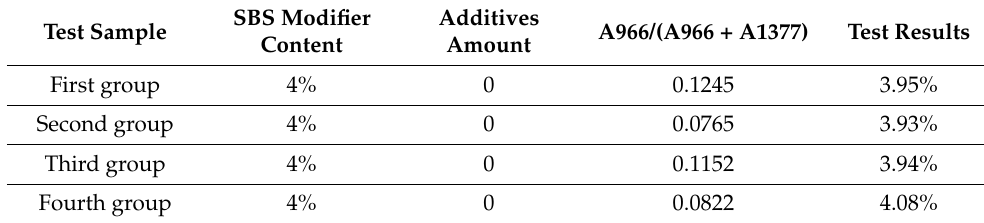
Table 3. Test results of 4% SBS-modified asphalt without